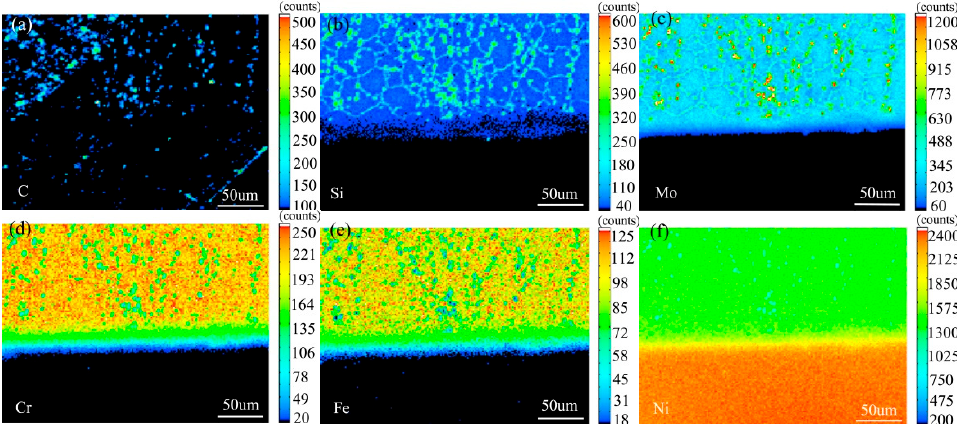
Figure 10. Composition distribution map of the diffusion couple sample of 2Si alloy and pure nickel after 800 °C/200 h heat treatment: ( a ) C, ( b ) Si, ( c ) Mo, ( d ) Cr, ( e ) Fe, and ( f ) Ni.